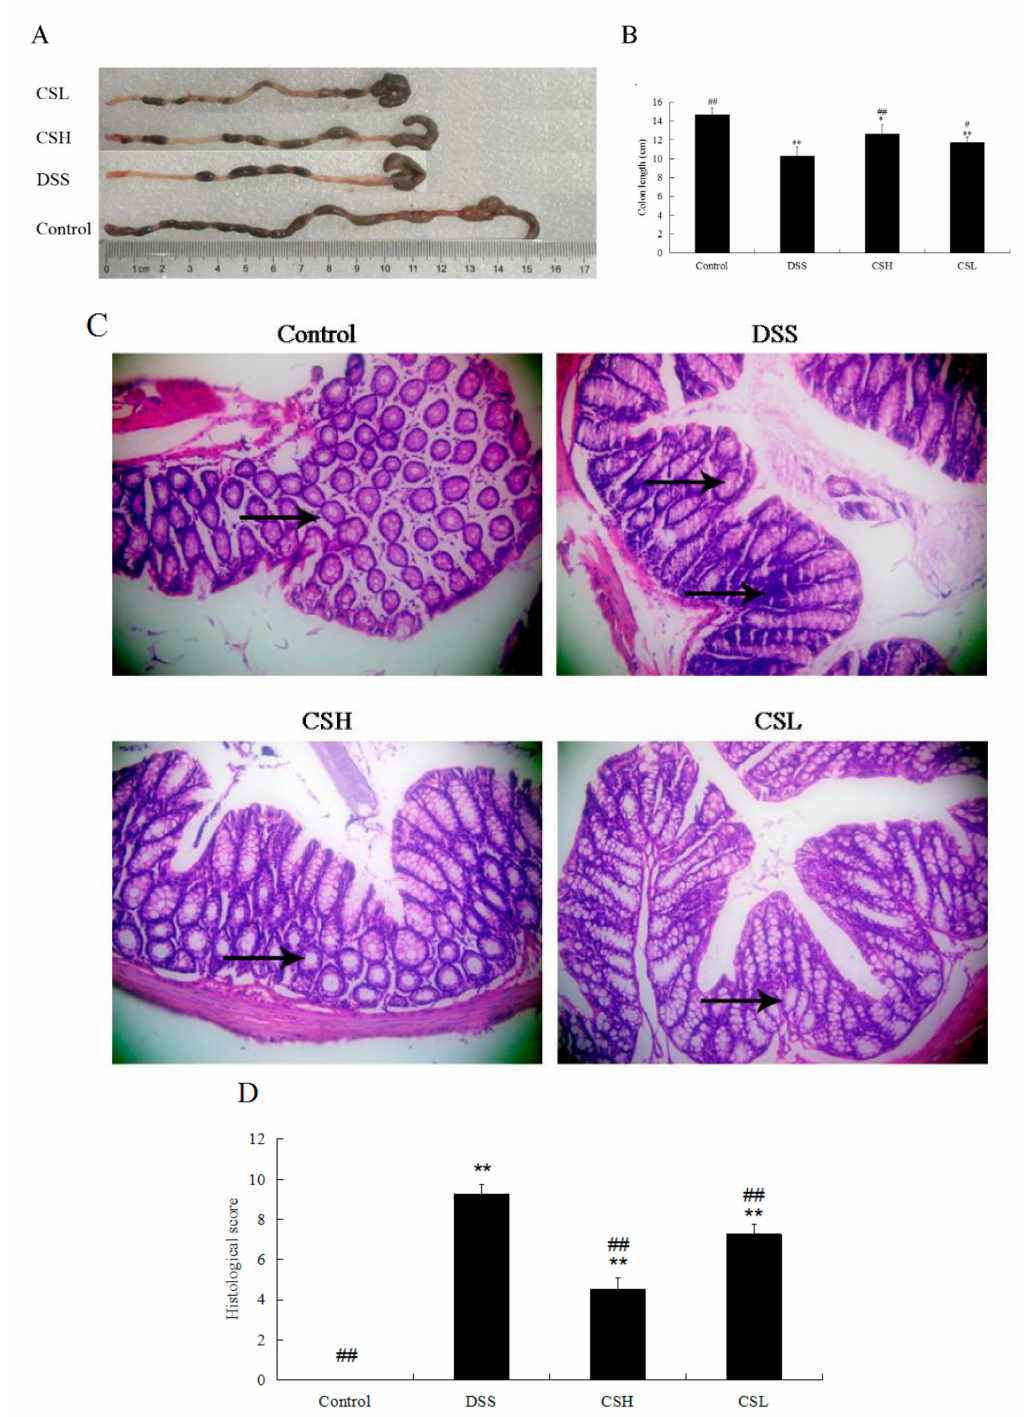
Figure 2. E ff ects of CS on colon length and histopathology in DSS-induced UC mice. Representative colons ( A ). Colon length ( B ). Histopathology (magnification 200 × ) ( C ). Histopathological scores ( D ). Arrows indicated the inflammatory infiltration, mucosal erosion, and damage of crypts. Control: normal mice; DSS: mice treated with 3% DSS alone; CSH: mice treated with DSS plus chitosan (250 mg / kg); CSL: mice treated with DSS plus chitosan (150 mg / kg). Values are expressed as mean ± SD ( n = 10). * p < 0.05 and ** p < 0.01 versus control; # p < 0.05 and ## p < 0.01 versus